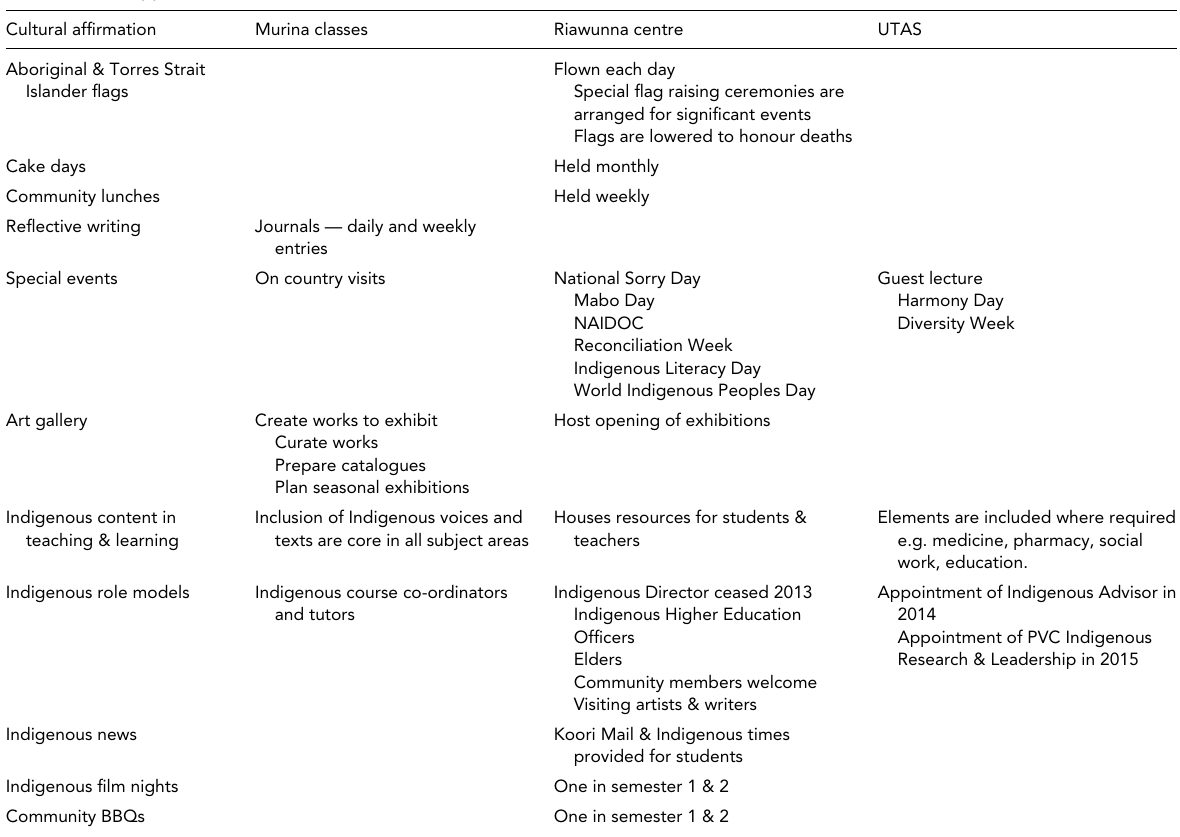
Strategies to Support Cultural Affirmation at